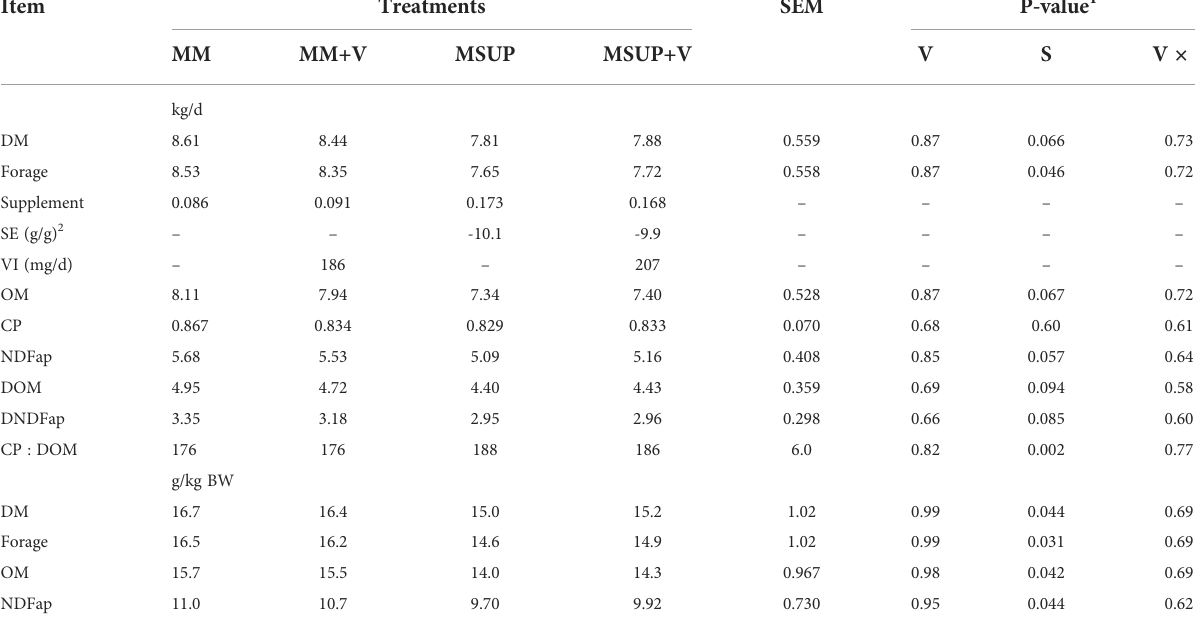
TABLE 3 Effects of feeding multiple supplement and, or virginiamycin on voluntary intake of Brahman heifers fed a high-quality tropical